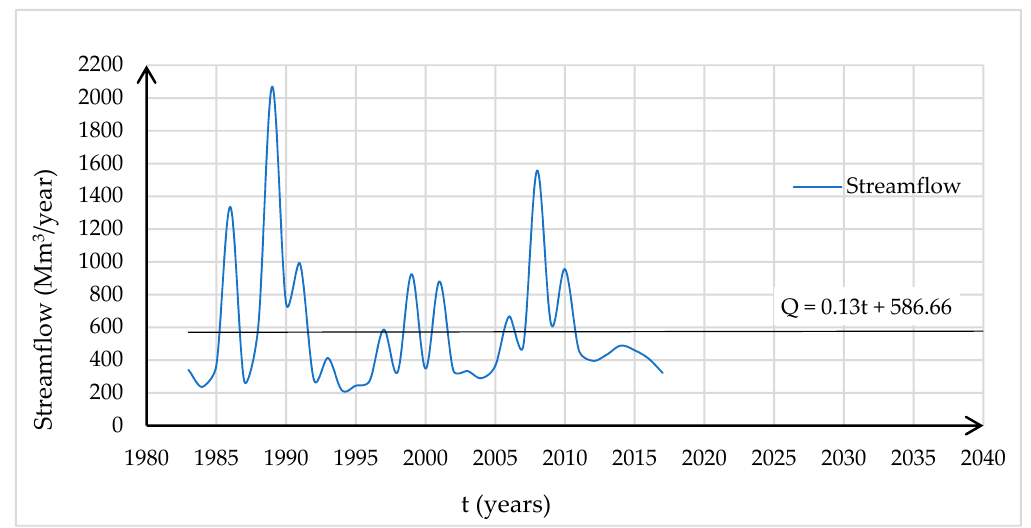
Figure 7. Annual streamflow variation at the outlet of Chongwe River Catchment.